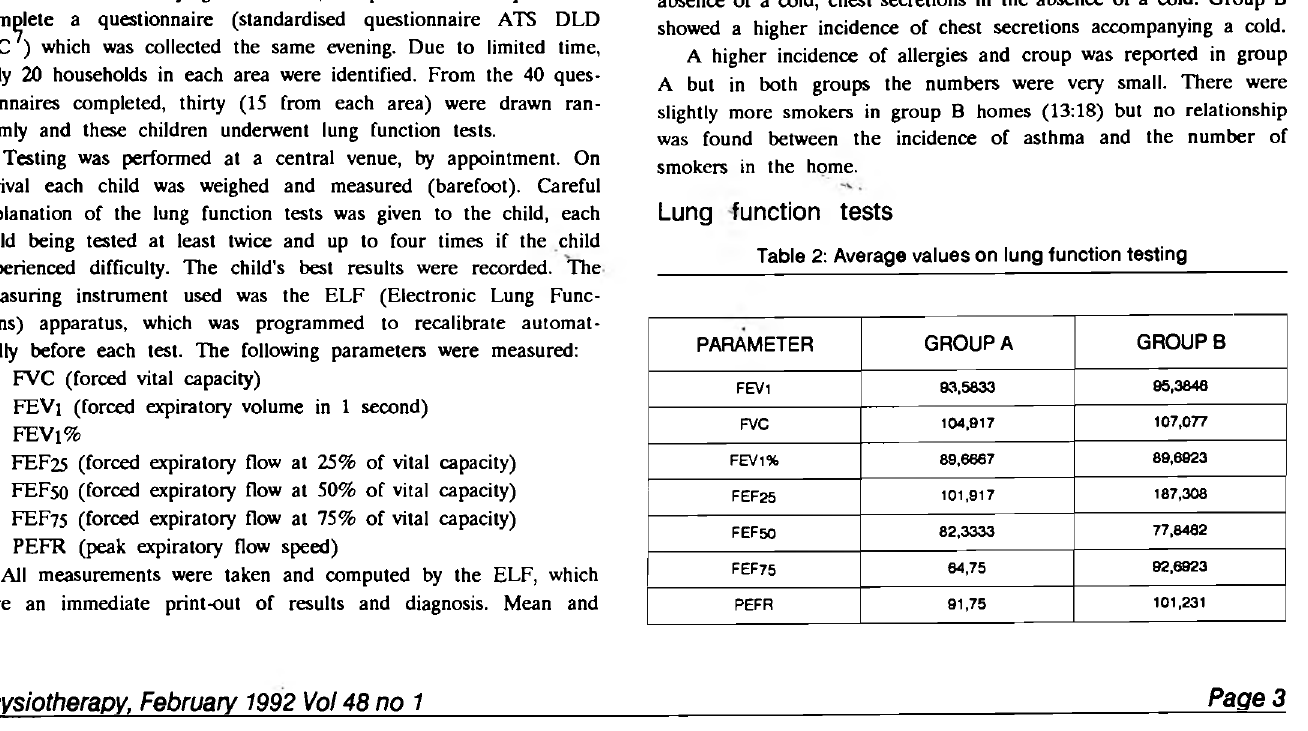
Table 2: Average values on lung function